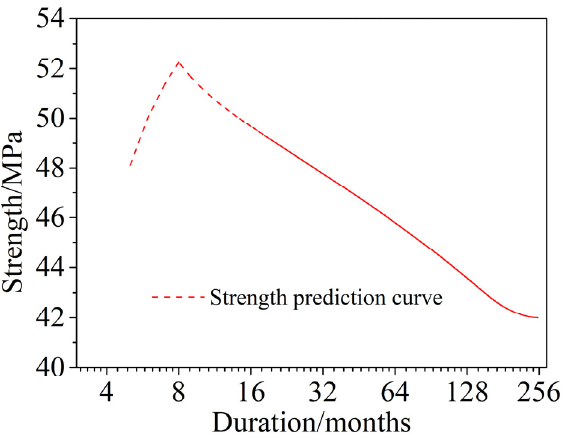
Figure 14. Prediction of time-dependent compressive strength of corroded concrete in a saline soil